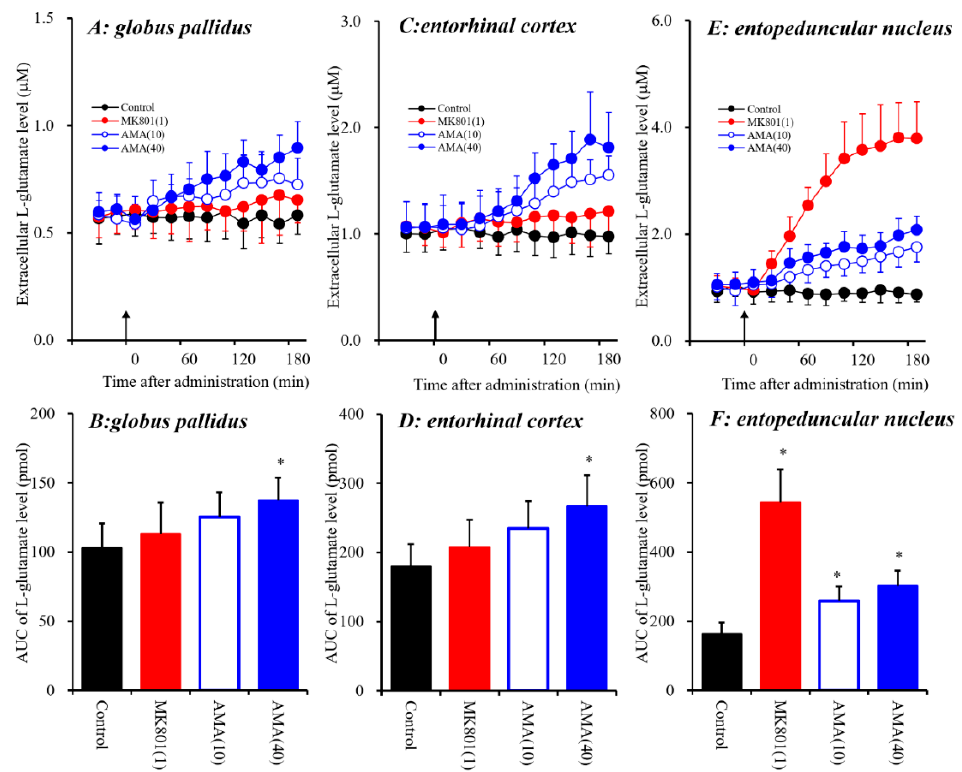
Figure 1. E ff ects of systemic administration of MK801 (1 mg / kg, i.p.) and amantadine (AMA) (10 and 40 mg / kg, i.p.) on extracellular L-glutamate levels in the globus pallidus ( A , B ), entorhinal cortex ( C , D ) and the entopeduncular nucleus ( E , F ). ( A , C , E ) indicate the e ff ects of intraperitoneal administration of MK801 and AMA (arrows) on extracellular L-glutamate levels in the globus pallidus, entorhinal cortex and entopeduncular nucleus, respectively. The initial perfusion medium was modified Ringer’s solution (MRS). After the stabilization of L-glutamate levels in the perfusate, each rat was administrated with MK801 or AMA (i.p.). Ordinates: mean ± SD ( n = 6) of extracellular L-glutamate level ( µ M); abscissa: time after administration of the target agent (min). ( B , D , F ) indicate the area under curve (AUC) value of extracellular L-glutamate levels (pmol) from 20 to 180 min after administration of the target agent in ( A , C , D ). * p < 0.05 relative to the control by a linear mixed model (LME) with Tukey’s post hoc test.